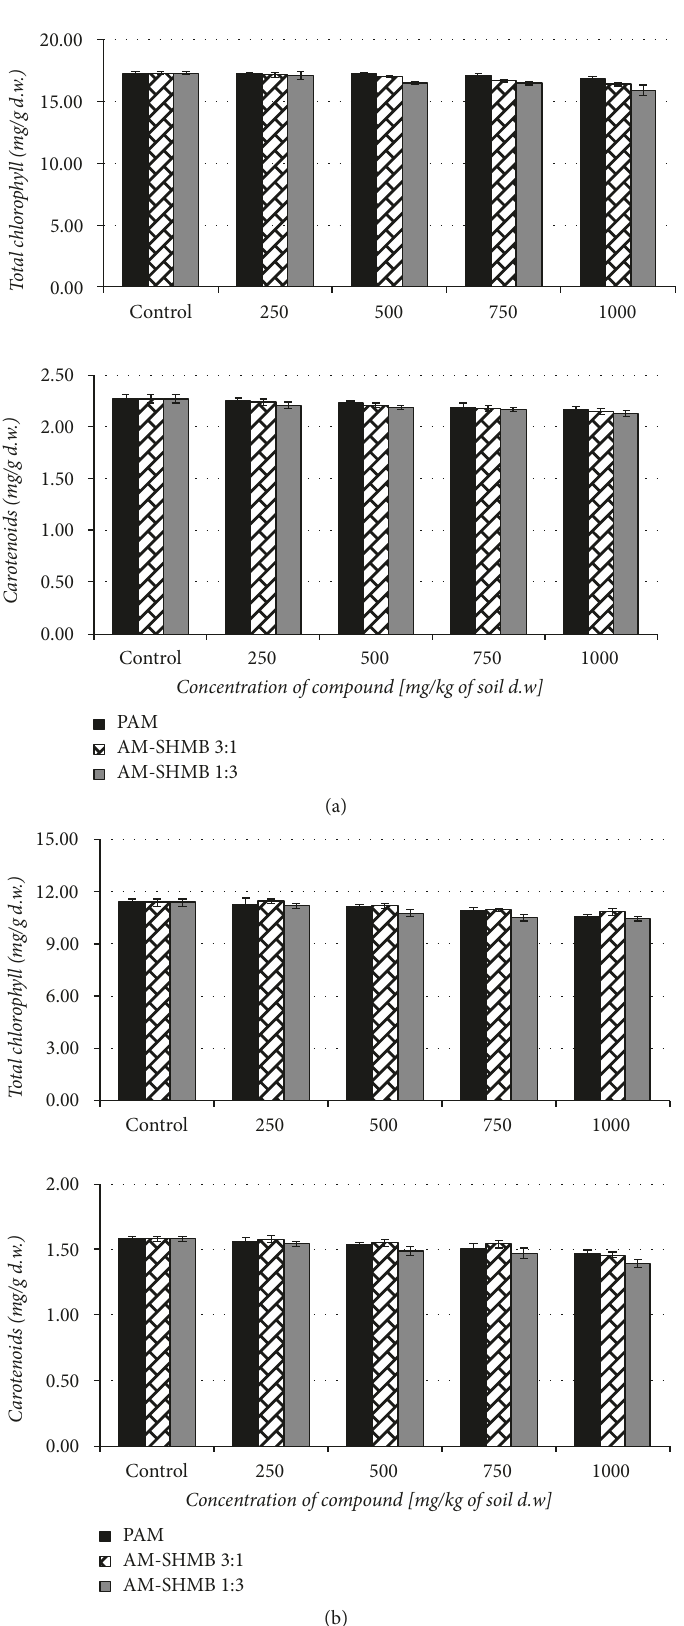
Figure 7: Effect of PAM, AM-SHMB 3:1, and AM-SHMB 1:1 hydrogels on the content of total chlorophyll and carotenoids in oat seedlings (a) and radish leaves (b). Data are expressed as mean ± SD of three replicates for each